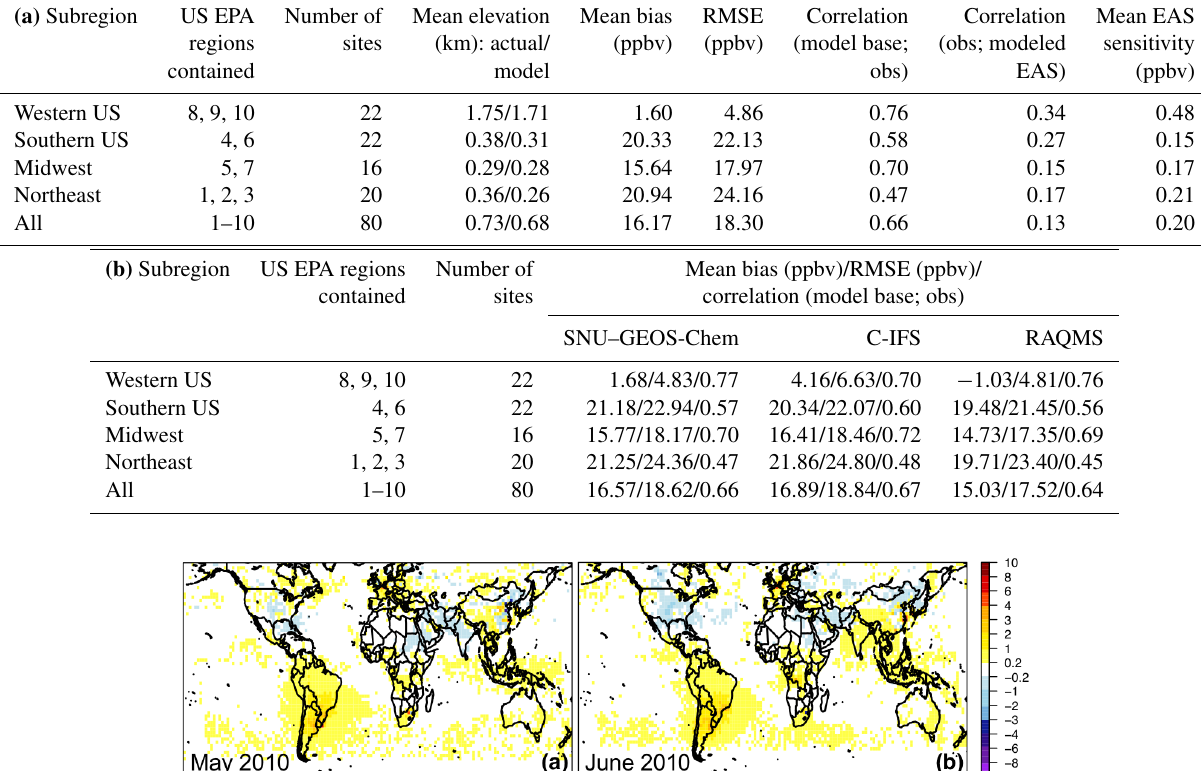
Figure 4. Evaluation of the GEOS-Chem adjoint base NO 2 product (recorded at near the satellite overpassing time) with the OMI NO 2 columns. The differences between OMI and GEOS-Chem (OMI-modeled) tropospheric NO 2 columns ( × 10 15 molec.cm − 2 ) are shown for (a) May and (b) June 2010. Details of the comparison are included in Sect.